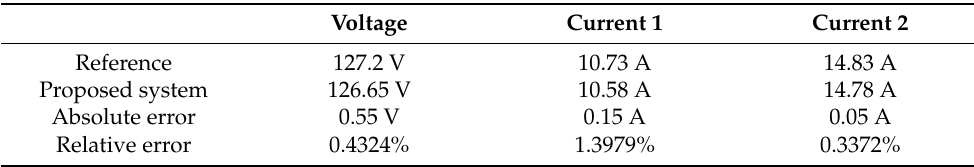
Figure 11. Photographs of local readings of electrical parameters. Table 5. Measurements and errors of local readings.